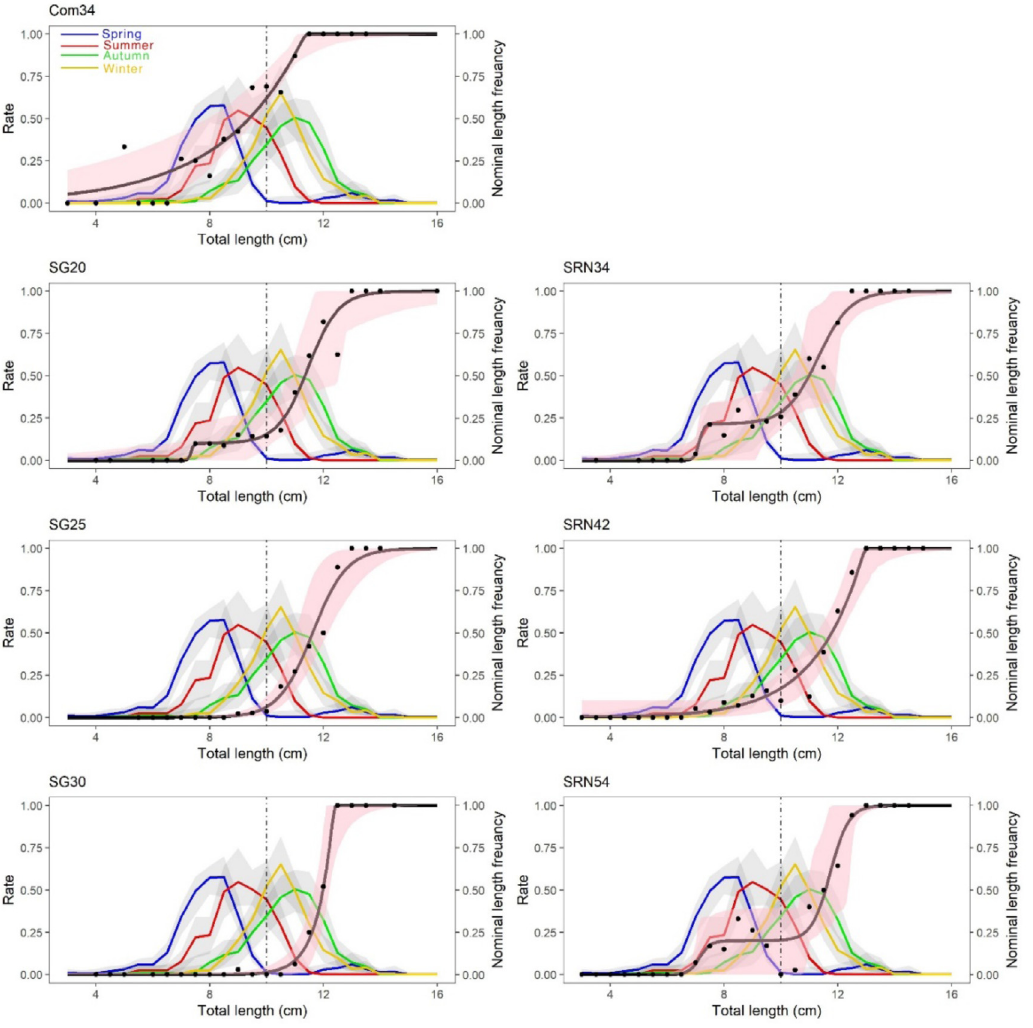
Fig. 3. Selectivity curves with Efron ’ s (1982) con fi dence intervals (black lines represent the selection curve, vertical dashed lines represent the MLS for P. leptodactylus and light pink areas describe the 95% CIs ) and the size distribution of the population of P. leptodactylus for the different fi shing seasons (light grey areas describe the 95% CIs ). Table 3. Summary of the AIC values derived from the selectivity models. Codends Logit Richard